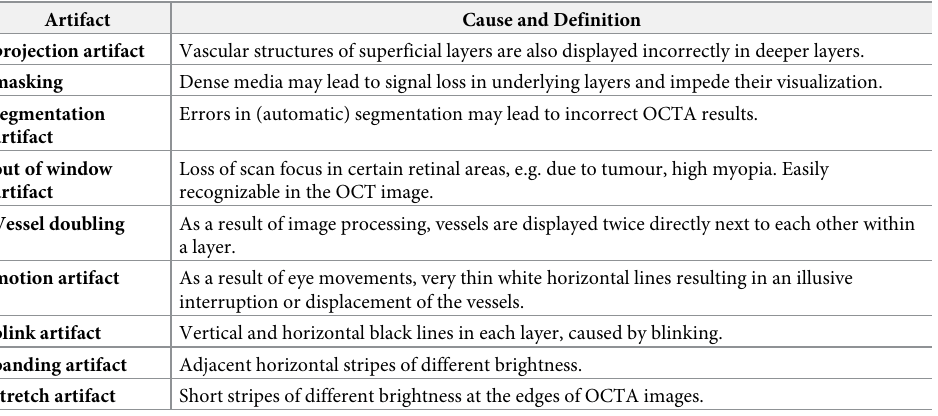
Table 1. Overview of artifacts including their cause and definition.